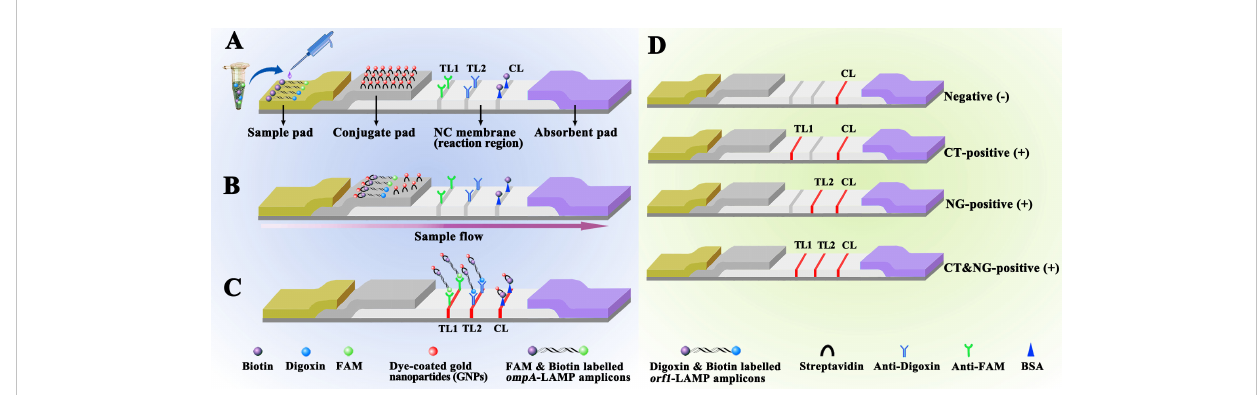
FIGURE 2 Schematic diagram showing AuNPs-LFB principles for visual mLAMP ampli fi cation product interpretation (A) mLAMP ampli fi cation products (0.5 m L) and running buffer (100 m L) were simultaneously added to the sample pad. (B) The running buffer containing the mLAMP products moves forward onto the conjugate pad and nitrocellulose membrane by capillary action. SA-AuNPss are hydrated, rapidly released, and combined with C . trachomatis or N. gonorrhoeae LAMP products at the conjugate pad. (C) FAM/biotin-labeled C . trachomatis LAMP products are captured by anti- FAM at TL1, Dig/biotin-labeled N. gonorrhoeae LAMP products are captured by anti-Dig at TL2, and SA-AuNPs are captured by biotin-BSA at the CL. (D) Interpretation of the mLAMP-AuNPs-LFB assay. C . trachomatis positive results are indicated by CL and TL1 bands on the AuNPs-LFB, N. gonorrhoeae positive results are indicated by CL and TL2 bands on the AuNPs-LFB, and C . trachomatis and N. gonorrhoeae positive results are indicated by TL1, TL2, and CL bands on the AuNPs-LFB. Negative results are indicated when only the CL band appears on the AuNPs-LFB. Key: CL, control line; TL1, test line one; TL2, test line two; CT, C . trachomatis ; NG, N. gonorrhoeae ; NC, nitrocellulose